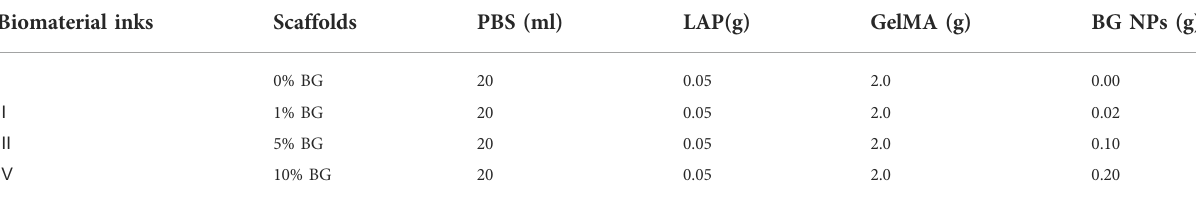
TABLE 1 The component of each group of biomaterial inks and scaffolds. Biomaterial inks